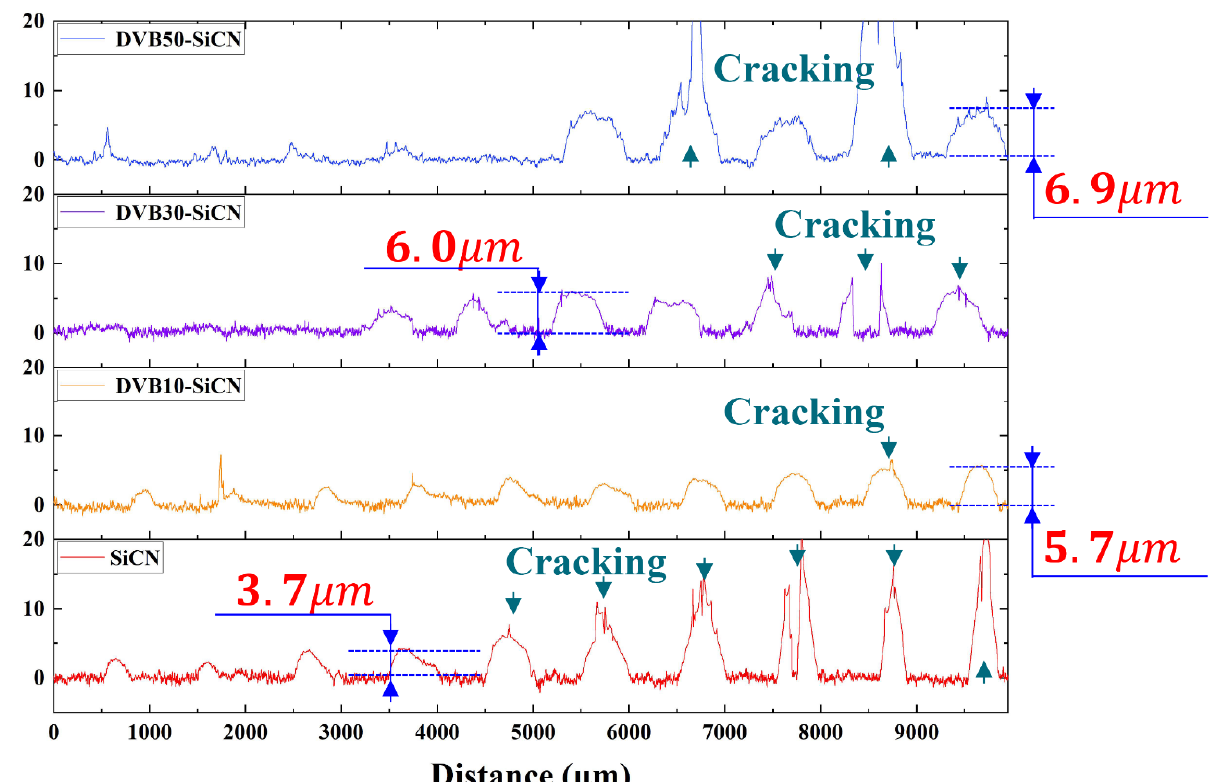
Figure 2. Surface profile of SiCN and DVB-modified SiCN lines.